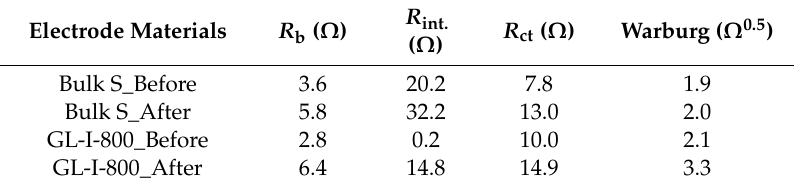
Table 4. Electrochemical impedance spectra (EIS) fitting results using a constant phase element (CPE)